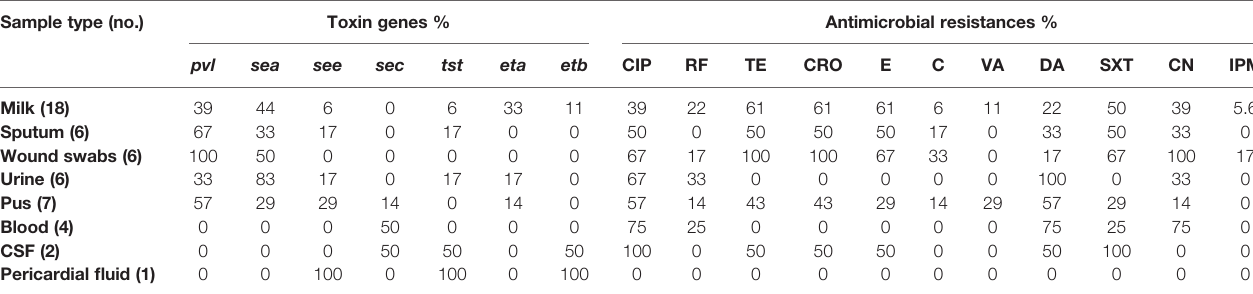
TABLE 1 | Percentages of toxin genes and antimicrobials resistances of ST239-MRSA among different sample types. Sample type